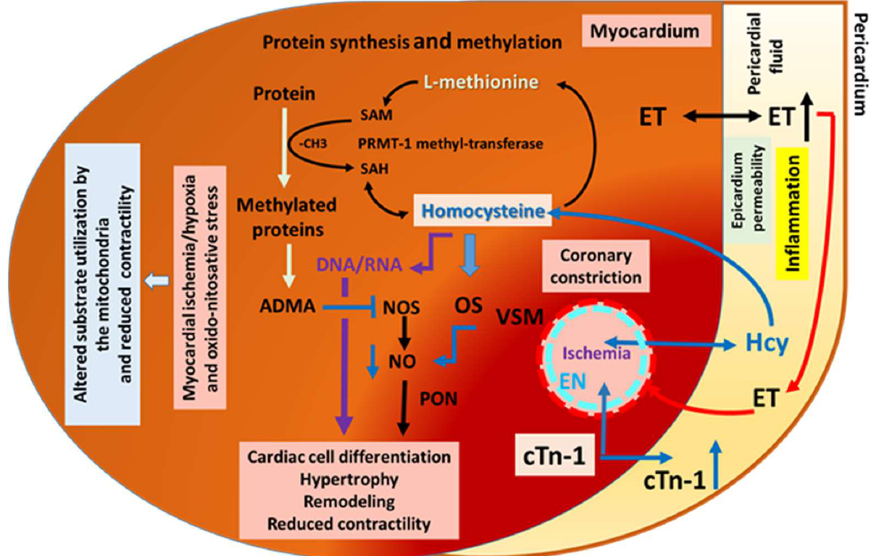
Figure 5. Summary of some of the mechanisms involved in the pericardial homocysteine-related cardiac remodeling and coronary dysfunction. SAM: S-adenosylmethionine, SAH: S-adenosylhomocysteine, ADMA: asymmetric dimethylarginine NOS: nitric oxide synthase, PON: peroxynitrite, ET: endothelin.